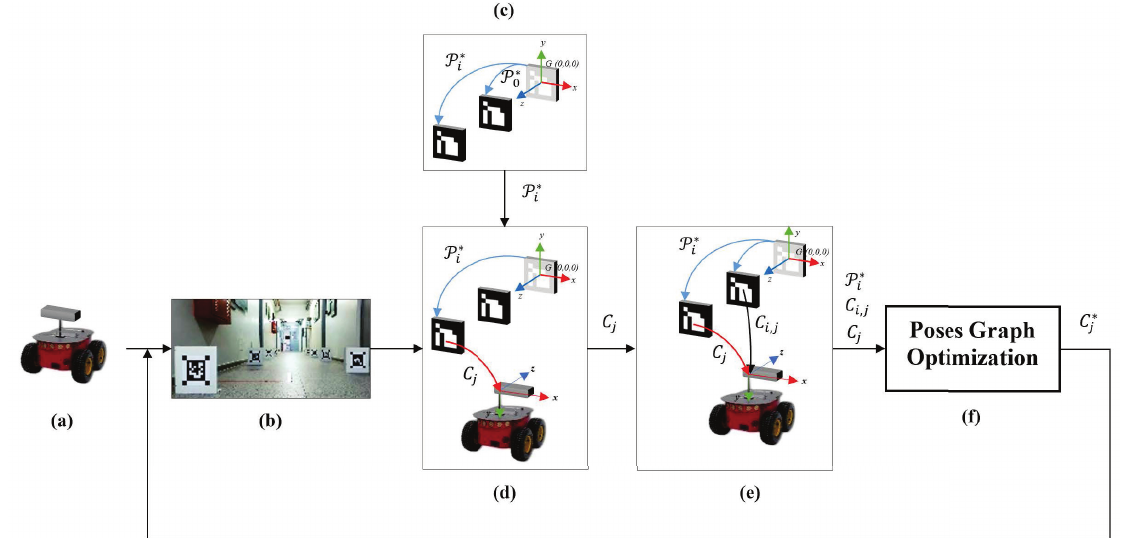
Figure 2. Diagram of steps for the camera localization. ( a ) Set up camera and robot. ( b ) Place a set of smart markers in a scene and capture an image. ( c ) Load the optimized markers’ poses, from the mapping stage. ( d ) Compute the camera pose captured by the fist visible marker. ( e ) Compute the camera poses captured by the rest of visible markers (in case of existing) in the image. ( f ) Using the markers’ poses of step ( c ), the camera pose of step ( d ), and the additional poses of step ( e ), create a graph of camera poses and optimize